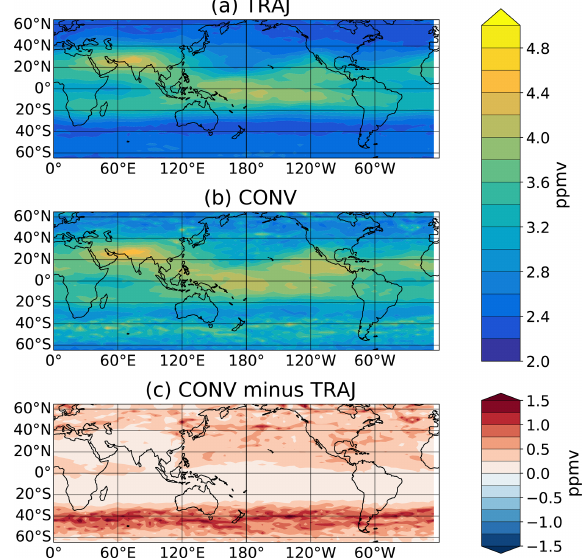
Figure 6. Boreal summer distribution of water vapour at 100hPa in 2008 for the (a) TRAJ and (b) CONV experiments and (c) their